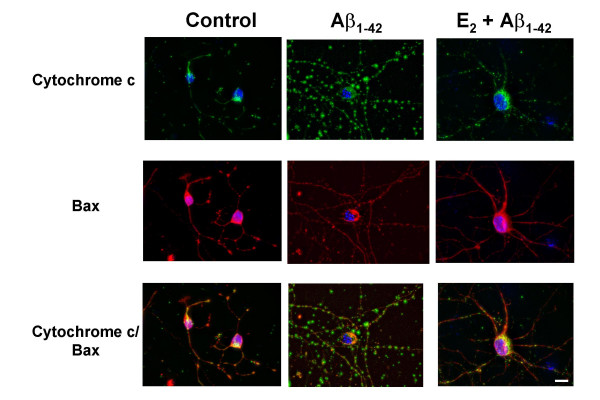
17β-estradiol prevents Amyloid beta1–42-induced Bax translocation and cytochrome c release. Primary hippocampal neurons pretreated with E2 (10 ng/mL; 48 hr) or vehicle control were exposed to Aβ1–42 for 24 hr and assessed for Bax and cytochrome c expression by immunocytochemistry. Treated neurons were double immunostained for Bax (Red) and cytochrome c expression (Green). Bar = 10 μm.